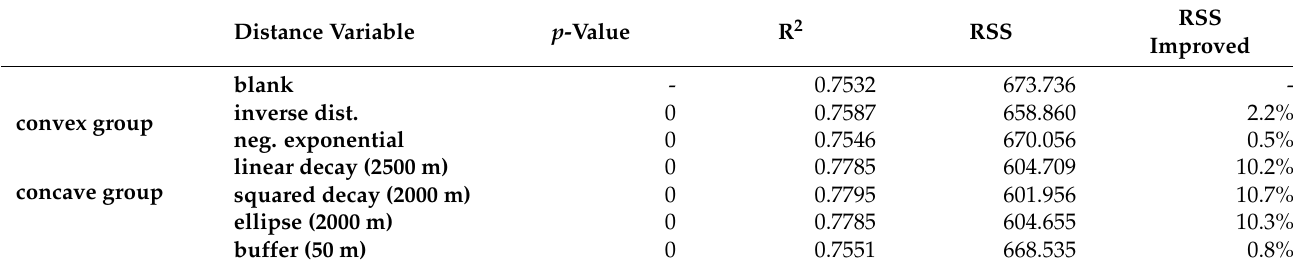
Table 5. RSS comparison of functions for distance-to-flood effect.